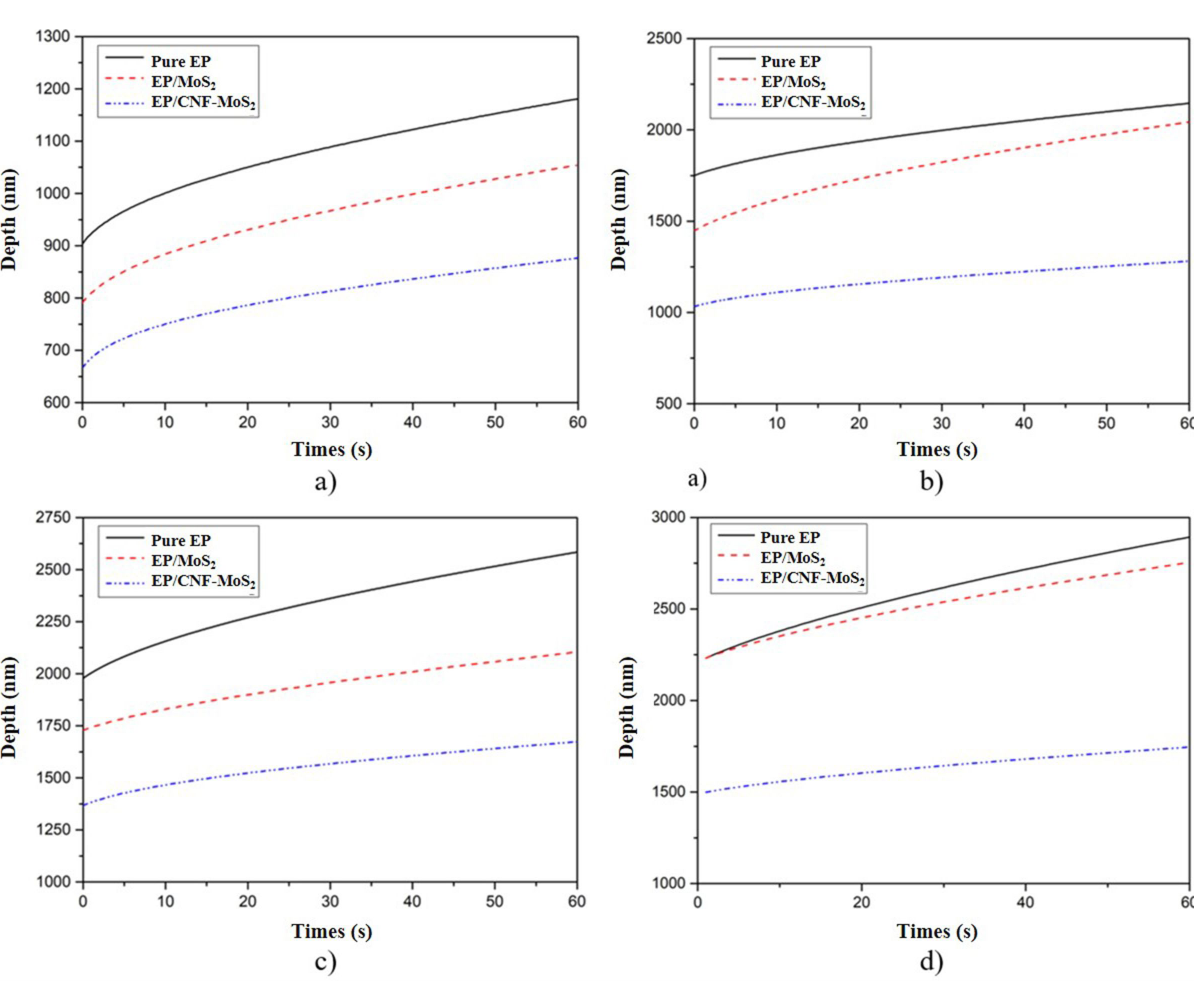
Figure 11: Variation of depth with holding time under different maximum load in the holding stage: a) 1 mN; b) 2 mN; c) 3 mN; d) 4 mN